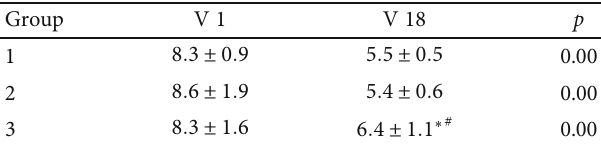
Table 3: The FBG among the three